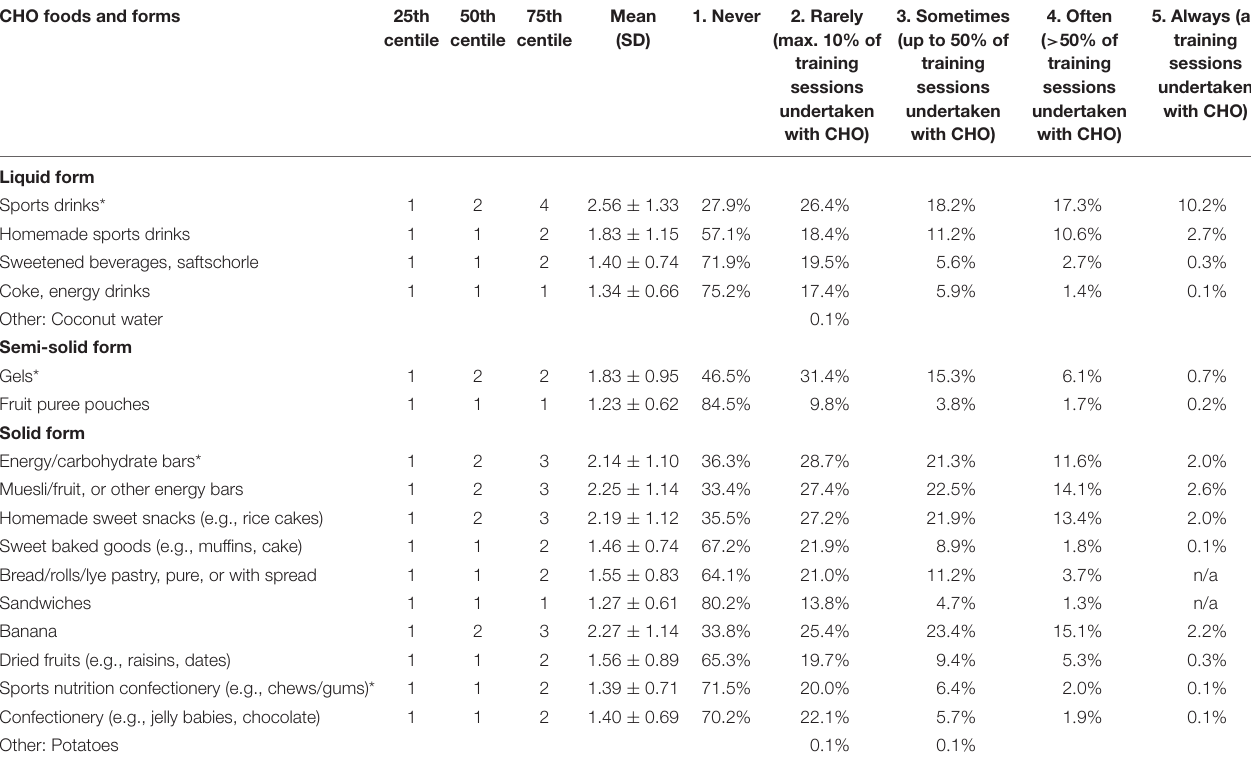
TABLE 1 | Intake frequencies of carbohydrate foods in endurance participants ( n = 1,032) during training at low-to-moderate intensities. CHO foods and